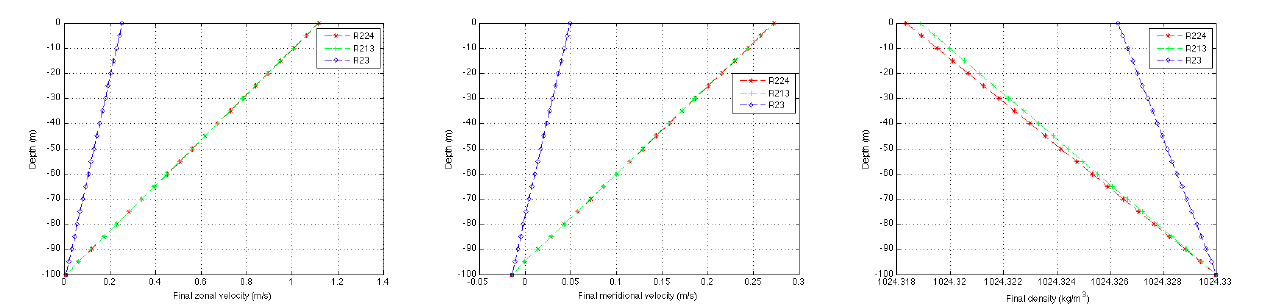
Fig. 5. Test 1: steady zonal velocity, meridional velocity and density profiles (from left to right) for models R 224, R 213 and R 23.